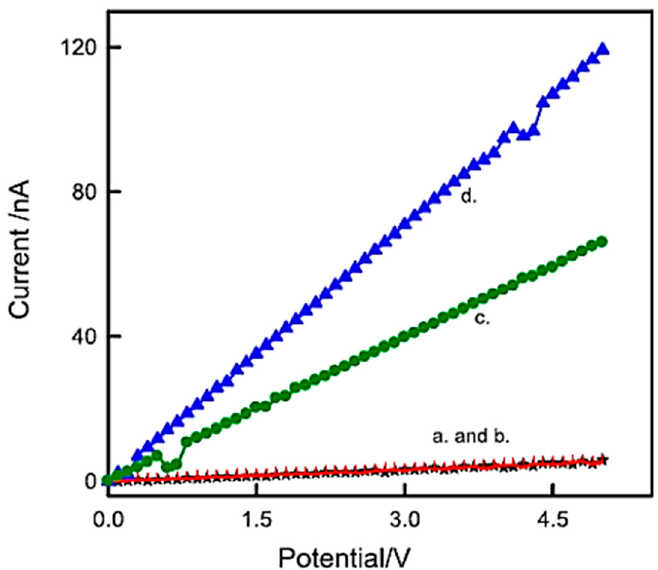
Figure 11. I-V characteristics of various polymer nanocomposite systems ( a ) PAN/PANI blend; ( b )